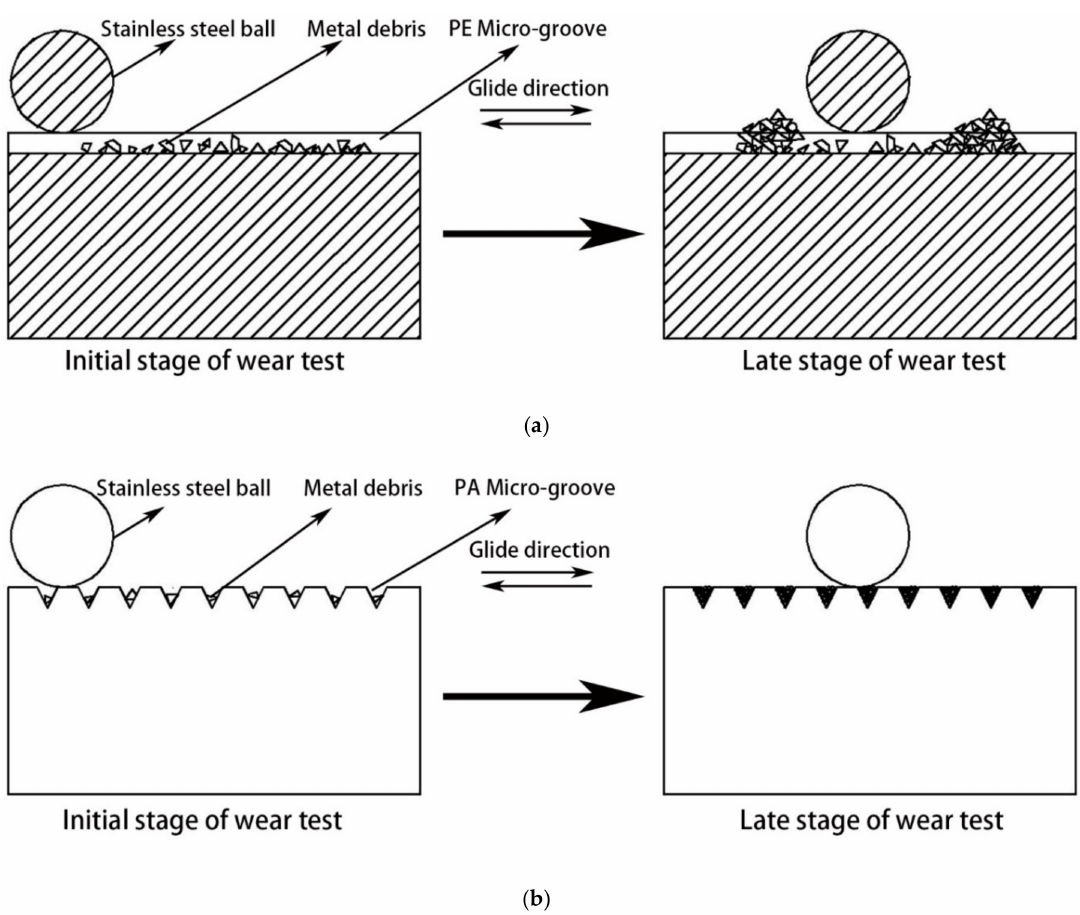
Figure 7. The anti-friction mechanism of micro-groove cemented carbide. ( a ) A-A cross-section of PE micro-grooves; ( b ) PA